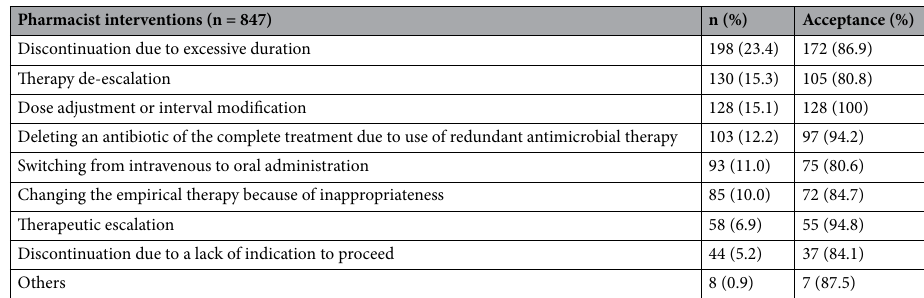
Table 2. Pharmacist interventions by intervention type and physician acceptance